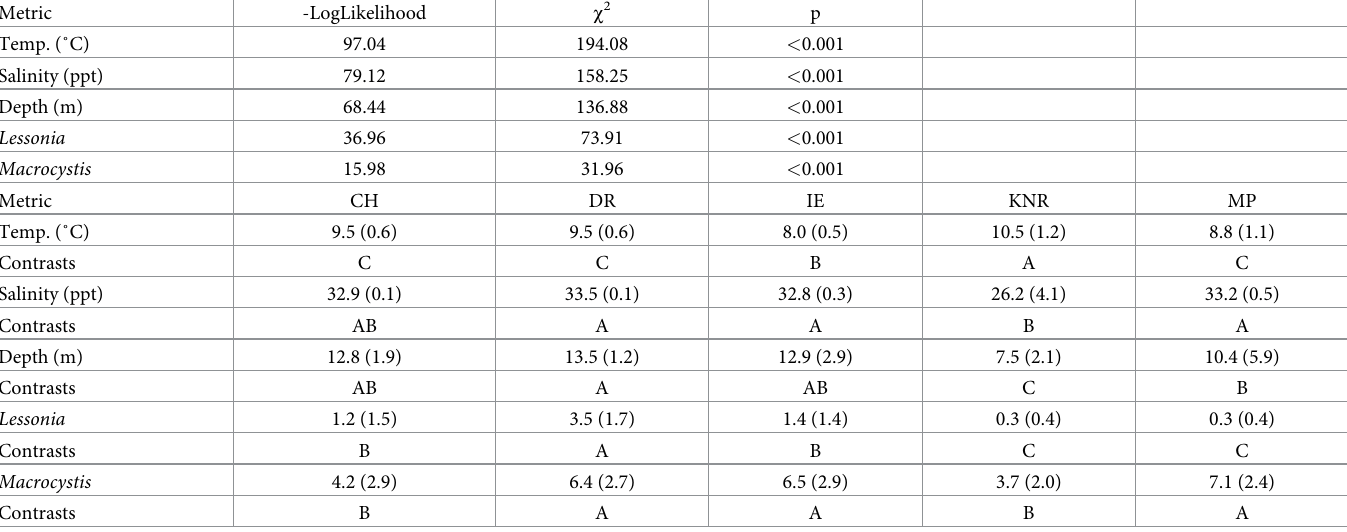
Table 1. Abiotic and biotic comparisons among regions in southern Patagonia. Results of Generalized Linear Models with Poisson distributions and log-link functions. Values among regions are means and one standard deviation. Pair-wise comparisons between regions were performed with contrasts using -Loglikelihood estimates. Regions with the same letter are not significant different ( α = 0.05). Region codes are described in the text and Fig 1. Metric -LogLikelihood χ 2 p Temp.